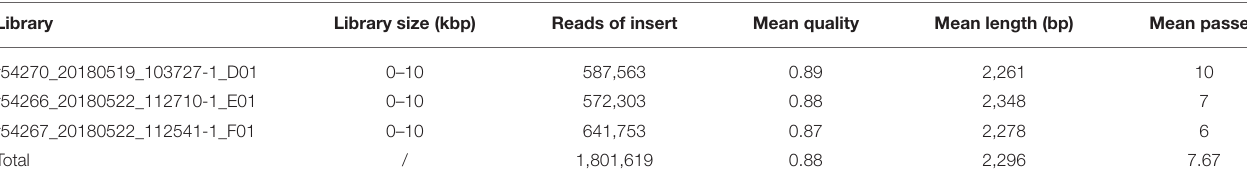
TABLE 1 | Data statistics of reads of insert.